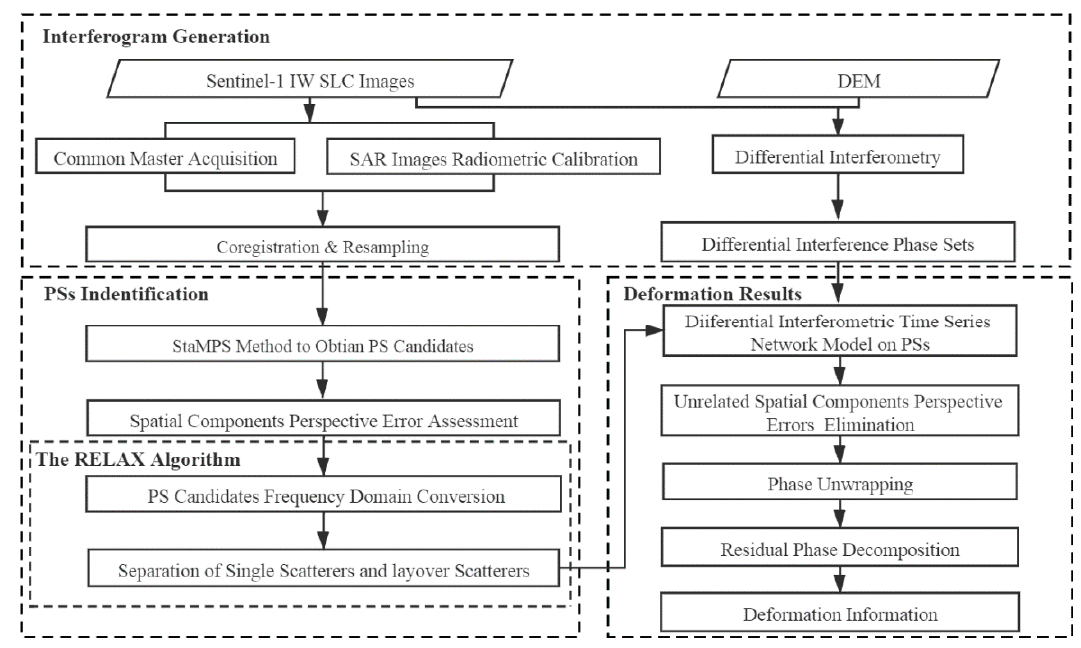
Figure 3. Workflow of the joint method PS-InSAR + RELAX technique used for land subsidence monitoring.